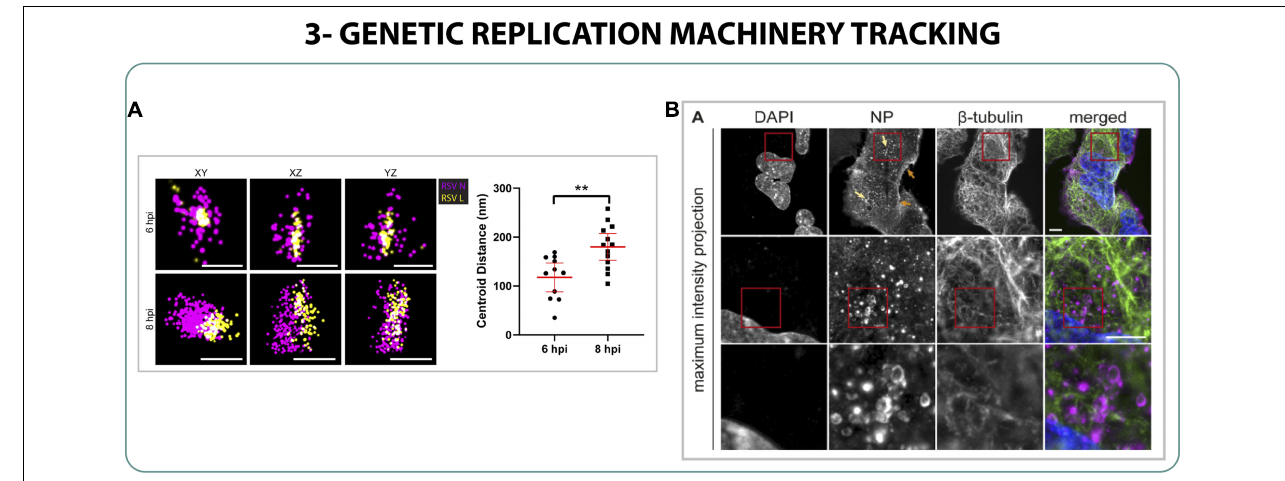
FIGURE 4 | Genetic replication machinery tracking. (A) STORM imaging and distance measurement of RSV ribonucleocapsid proteins L (yellow) and N (magenta) at 6 and 8 h post infection (hpi). Scale bar 200 nm (Blanchard et al., 2020). (B) Expansion/light sheet of cells infected with live attenuated influenza NPs (Mascheroni et al., 2020). A Welch t-test was performed, where n = 10 and ** p <